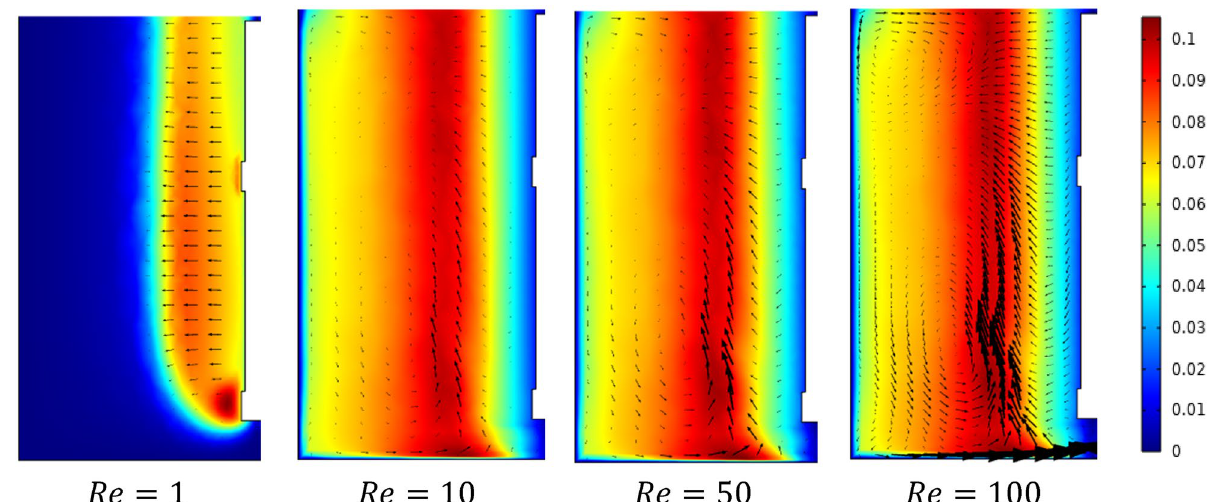
Figure 5. Contour velocity and arrow velocity field distribution in the vertical median section on the stirred tank for different Reynolds numbers.